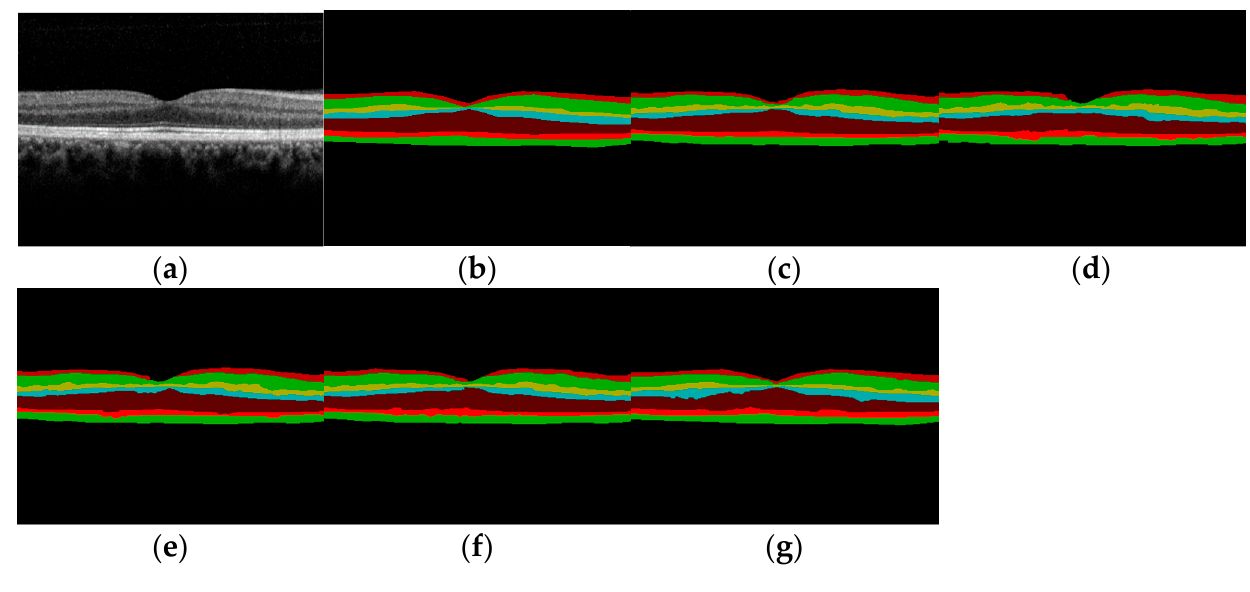
Figure 11. Qualitative comparison of OCT image segmentation: ( a ) original OCT image; ( b ) marked with Expert 1; ( c ) annotate with Expert 2; ( d ) U-Net prediction; ( e ) ReLayNet prediction; ( f ) TransUNet prediction; ( g ) the proposed method prediction.